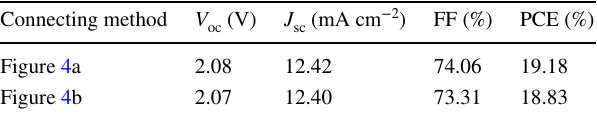
Table 2 Performance data for 2-T tandem solar cells made by using different connecting